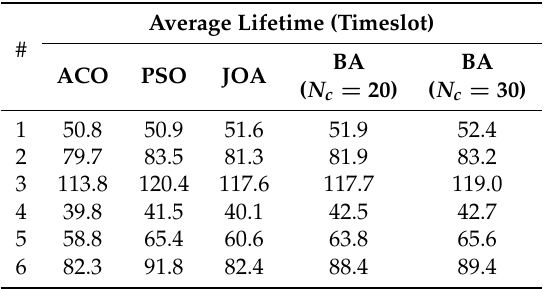
Table 2. Average lifetime in the first experiment.